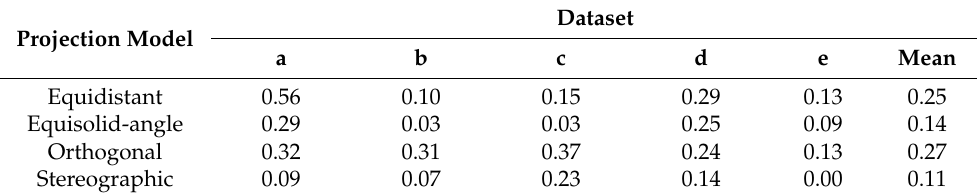
Table 7. Absolute error of focal length (pixel) in simulation experiments.